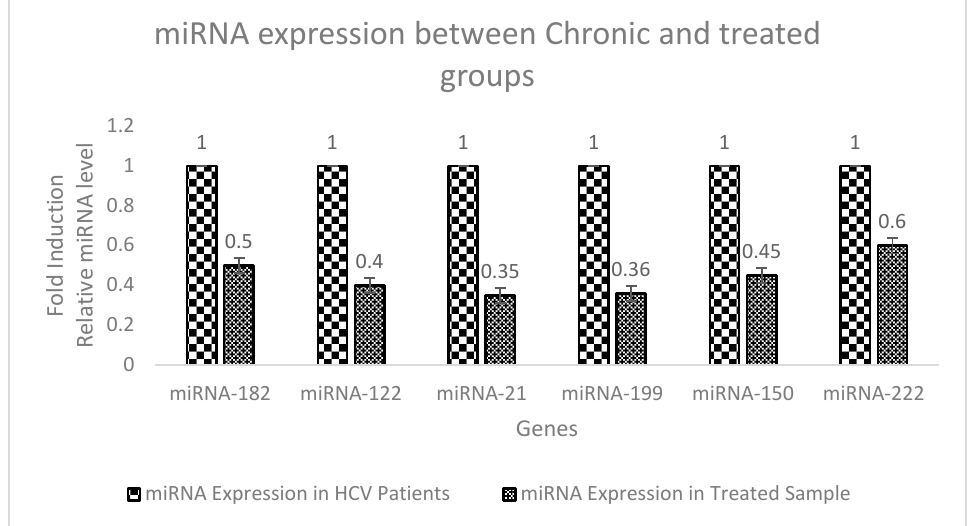
Figure 5. Graphical representation of the expression analysis of miRNAs in the diseased and treated groups using real-time PCR .